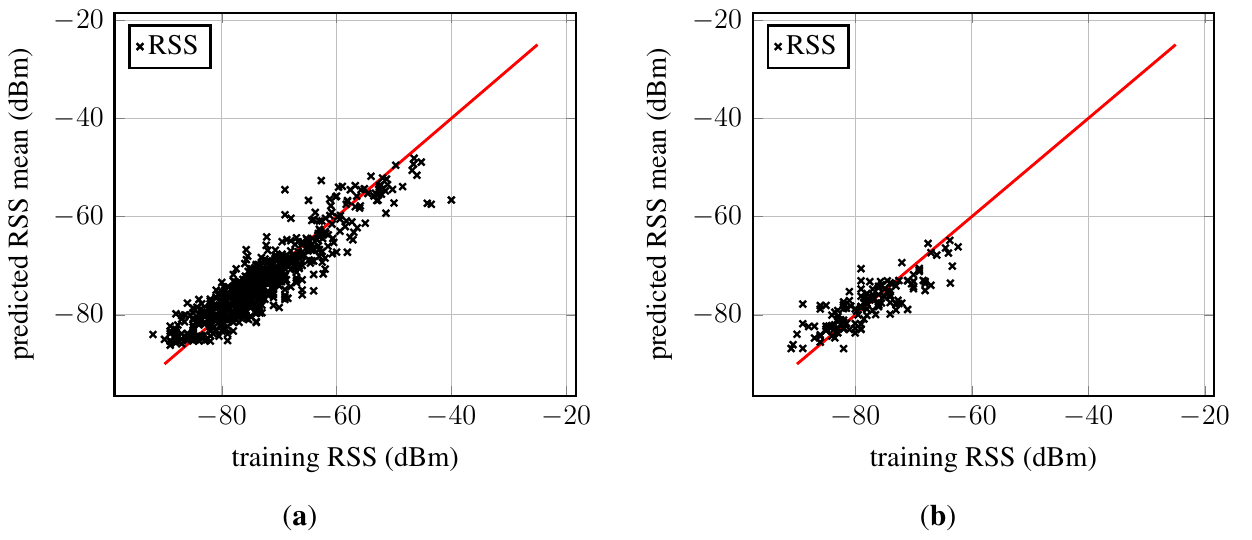
Figure 7. Predicted RSS versus training RSS for two access points: ( a ) An access point with many fingerprints; ( b ) an access point with few fingerprints. The red line indicates under- and over-fitting of the training data.